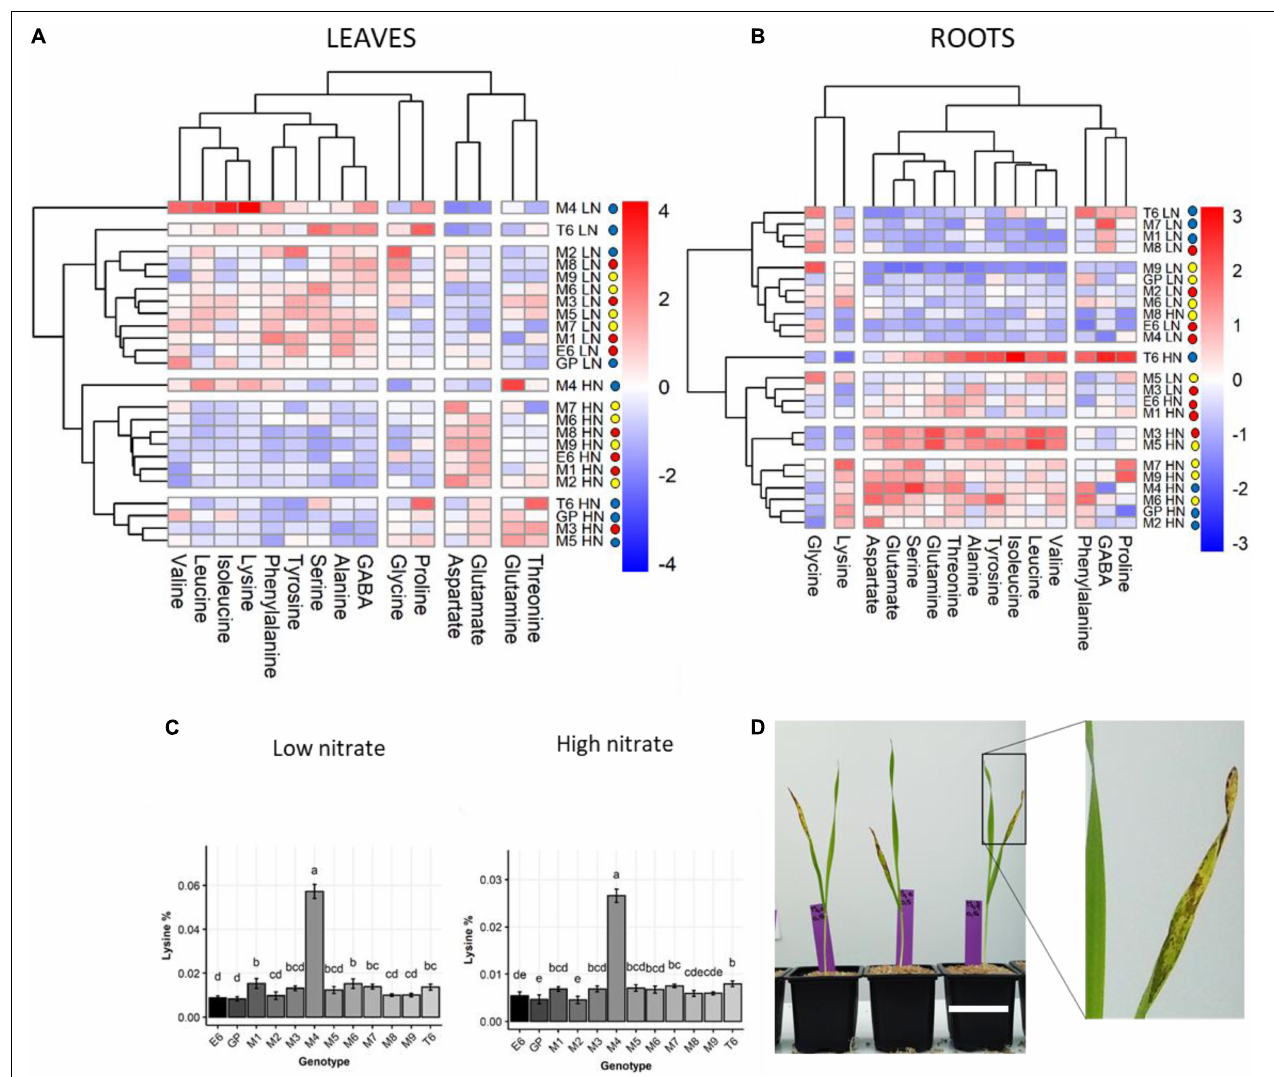
FIGURE 4 | Genetic diversity of amino acid composition in barley leaves and roots under LN and HN. Plants were grown for 14 days under LN or HN then leaves and roots were harvested separately and frozen under liquid nitrogen. The following freezing in liquid nitrogen AA was quantified by HPLC as indicated in the Material and methods. (A,B) Hierarchical clustering analysis of the amino acid % under LN or HN in leaves and roots, respectively, showing genotypes sharing similar amino acid profiles. The color scale is based on the value of the normalized mean for each trait. Normalization was made for the LN and HN conditions separately. The colored circles in front of each genotype label represent the above-mentioned group A, B, C in Figure 2 . HCA was constructed with the R package. (C) Level of lysine in leaves of each genotype under HN or LN. The different letters indicate values significantly different at P < 0.05 as determined using R-ANOVA Newman–Keuls (SNK) comparisons. (D) Picture showing the senescing phenotype of M4 leaves under LN. An enlargement of the senescing leaf is shown on the right. White scale bar = 5